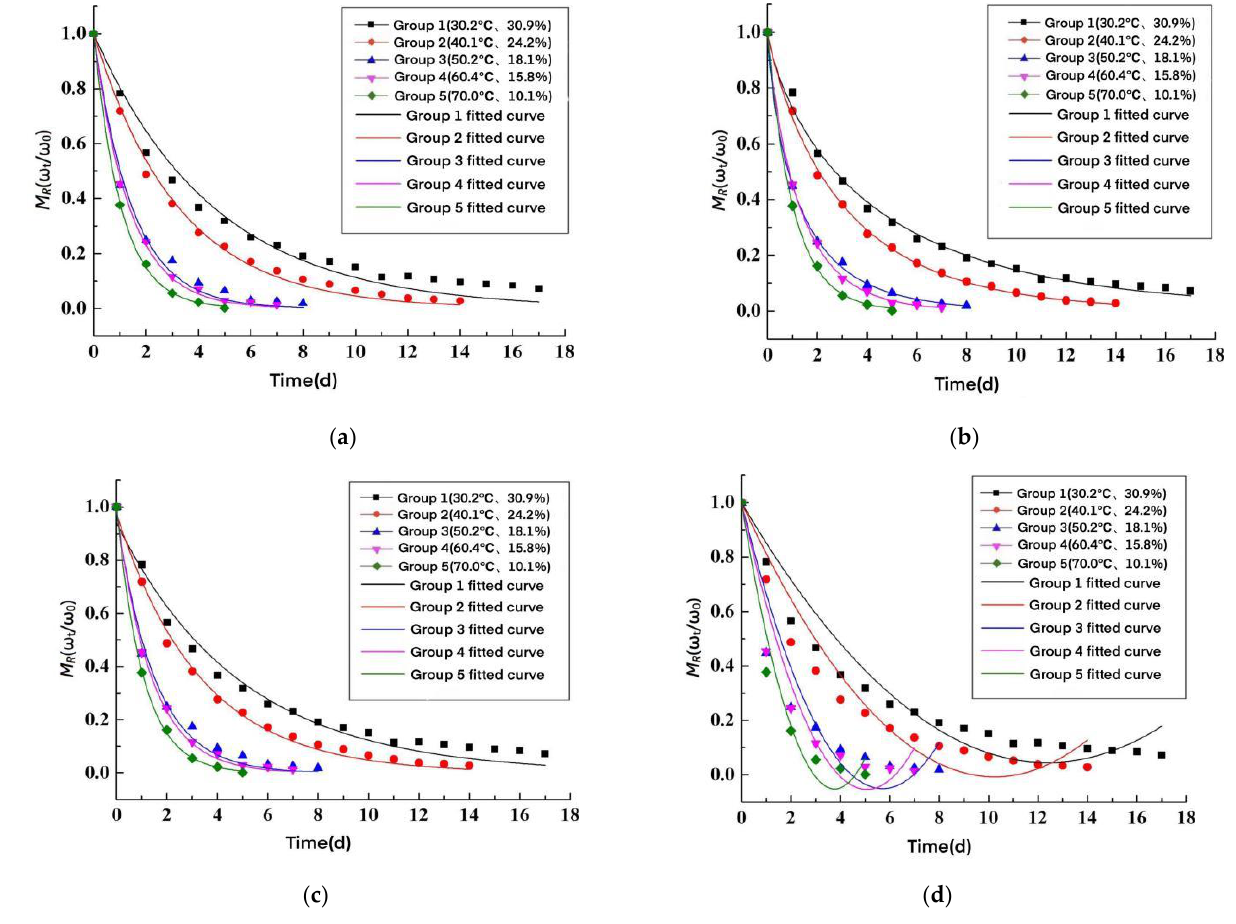
Figure 3. Comparison between the measured values and the theoretical model. ( a ) The Lewis model, ( b ) Page model, ( c ) Henderson – Pabis model, and ( d ) Wang – Singh model. Table 5. Calculation parameters of the drying kinetic model.